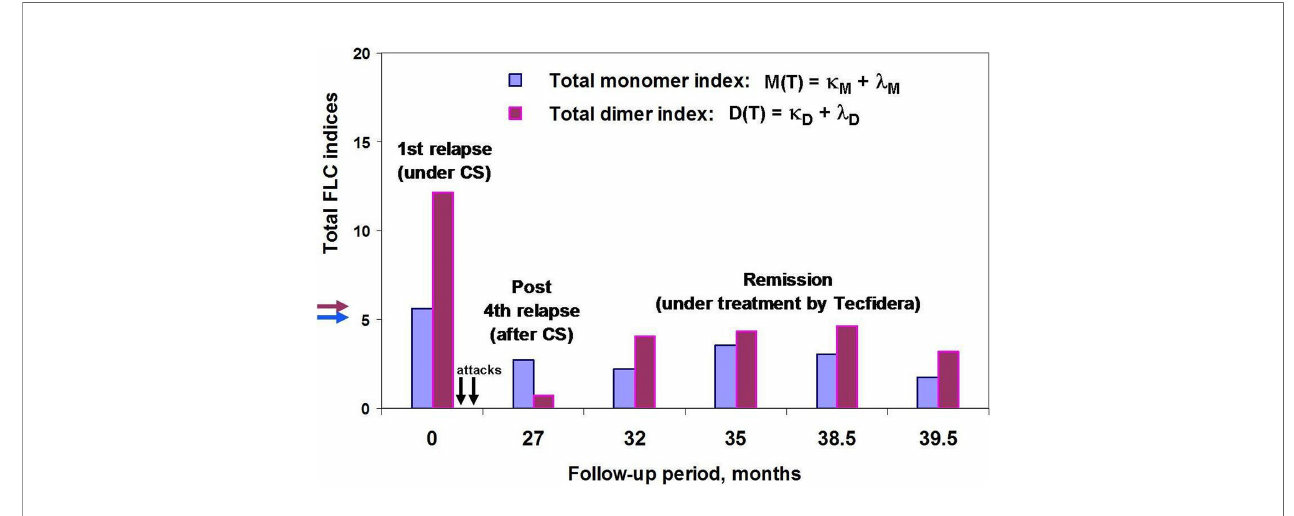
FIGURE 5 | POMS patient #46 follow-up using saliva FLC test. Vertical axis y shows total FLC monomer and dimer indices, namely, M(T) = ( k M + l M ) – blue, D(T) = ( k D + l D ) – purple. The arrows on the vertical axis y (blue and purple) indicate the cut-off values of indices to distinguish between normal and abnormally high FLC levels. Horizontal axis x – follow-up period (months); the arrows indicate the second and third attacks, 2 and 5 months after the fi rst one (no saliva samples were